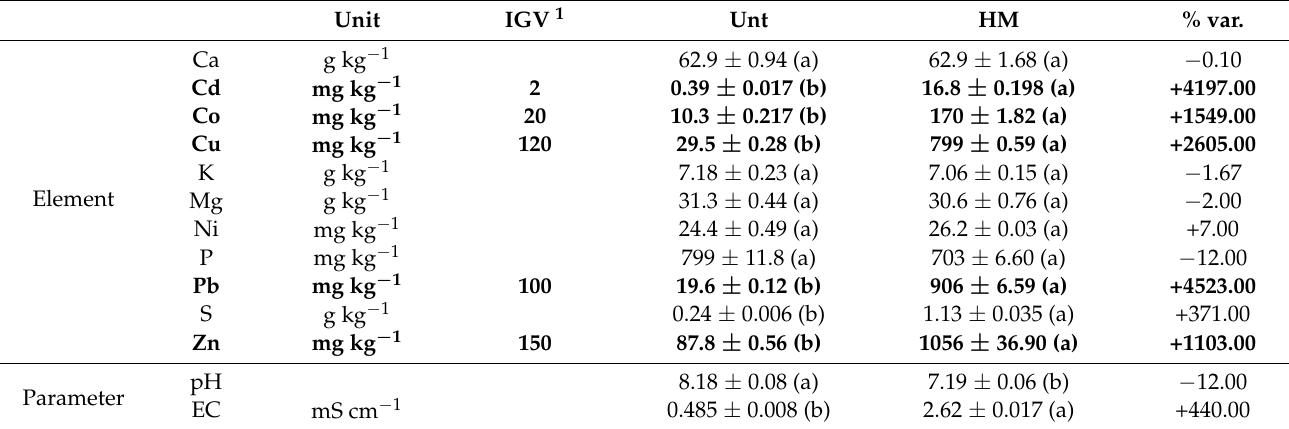
Table 1. Total element concentrations (different units refer to soil dry weight (DW); ± standard error (SE); n = 4), pH and electrical conductivity (EC) in soil contaminated with heavy metal (HM) vs. uncontaminated controls (Unt), and % variation vs. Unt. Letters in brackets indicate significant differences between treatments (Newman–Keuls test, p ≤ 0.05). The elements artificially added to the soil are highlighted in